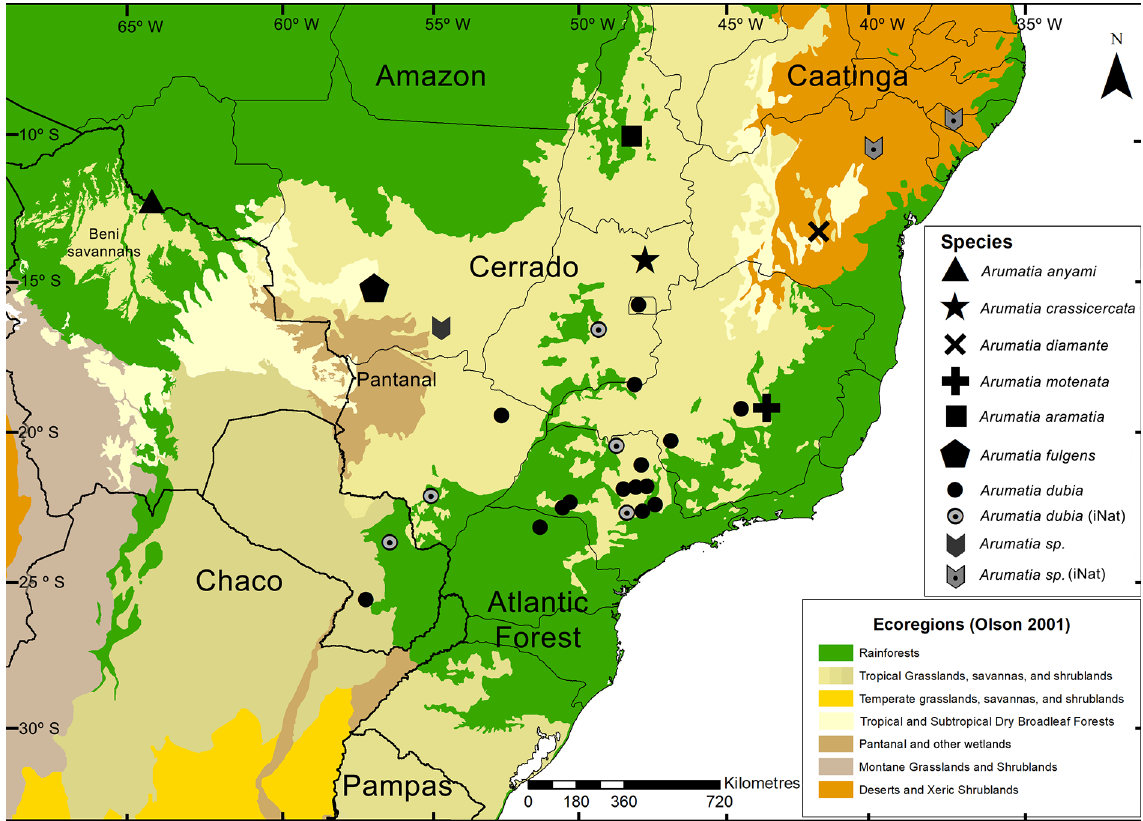
Fig. 52. Distribution map of species of Arumatia Ghirotto gen. nov. in central South America. Brazil is further divided into states which are shown in a thinner line. Note that grey dotted circles represent photographic records of Arumatia dubia gen. et comb. nov. from the iNaturalist (iNat) online platform, the black shield represents an unidentified nymph of Arumatia gen. nov. from MZUSP collection and the grey dotted shields represent photographic records of a potentially new species from